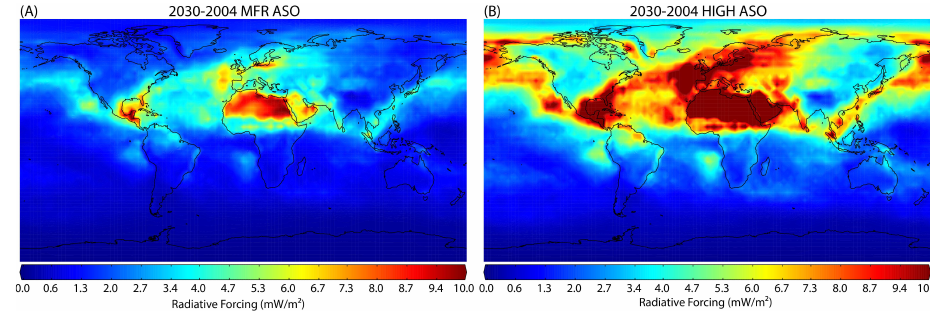
Fig. 9. BC in air RF 2004–2030 (mWm − 2 ) for the ASO season. (A) MFR scenario. (B) HIGH scenario.